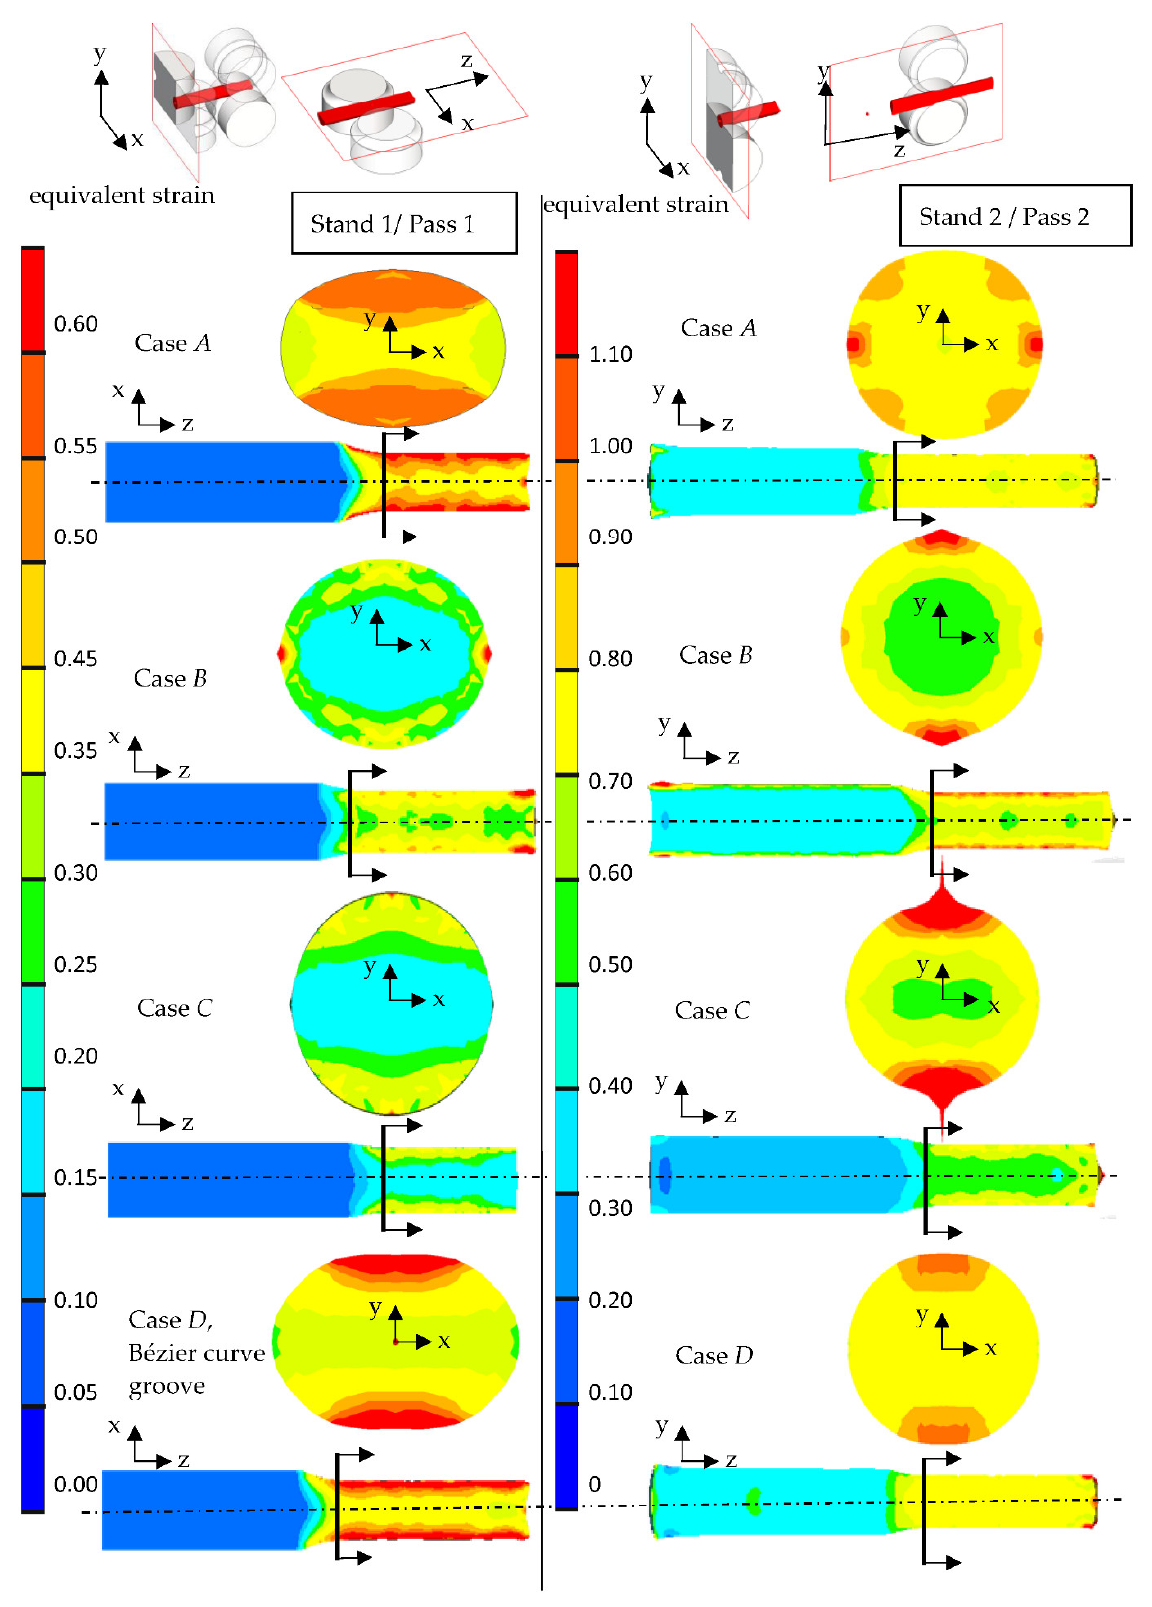
Figure 7. The equivalent strain distributions at the cross sections along the vertical direction and the rolling direction.